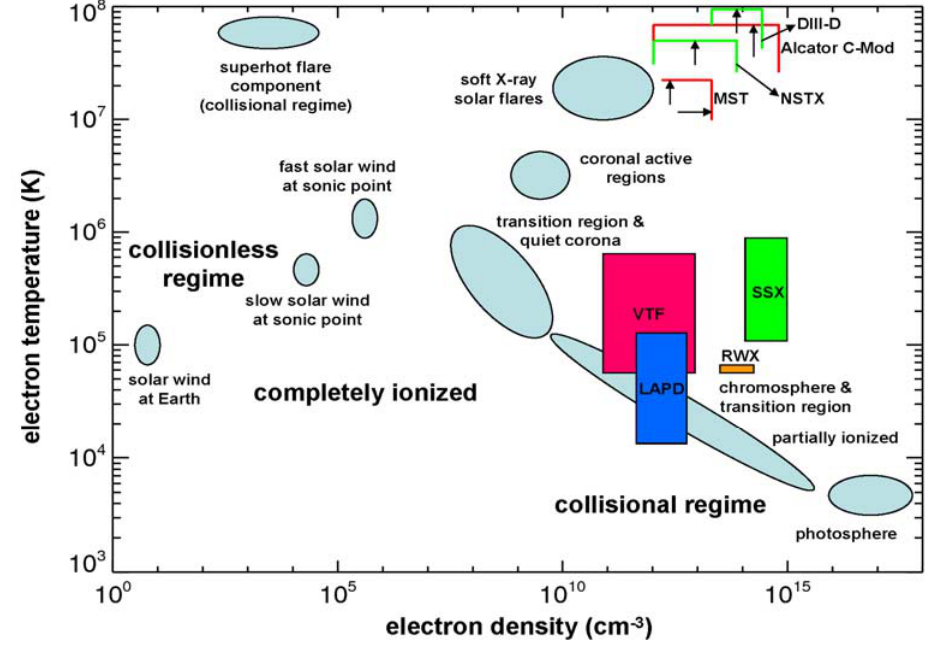
Figure 1. The electron density and temperature operating regimes of an illustrative group of current laboratory confined plasma experiments, plotted together with the observed parameter space that is accessed by elemental heliospheric